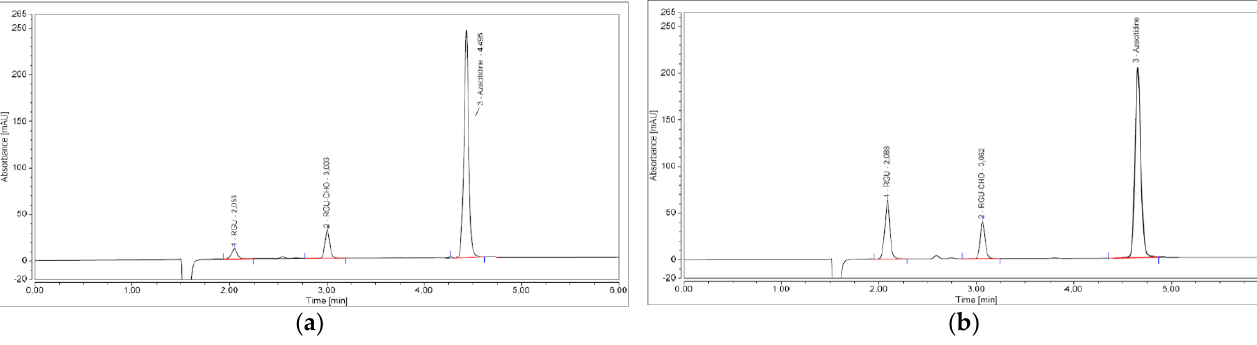
Figure 4. Comparison of chromatograms between the day the Vidaza ® (25 mg/mL) was reconstituted ( a ) and the 96 h after the reconstitution ( b ): we can observe a decrease of the azacitidine peak that favors an increase of the RGU peak.